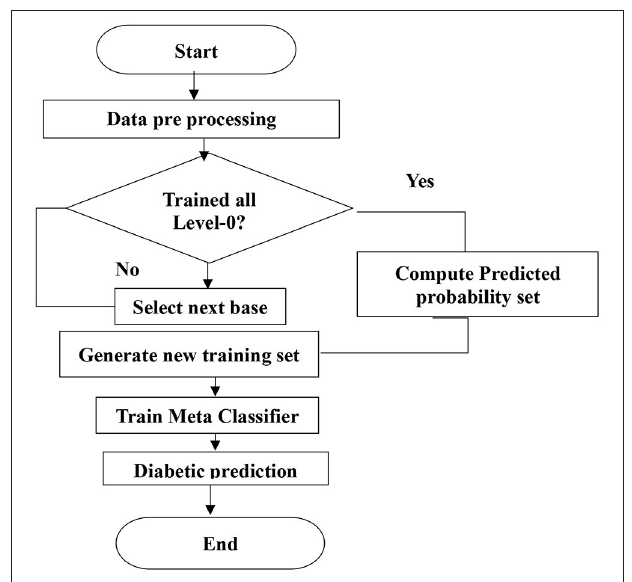
FIGURE 5 | Proposed system flow